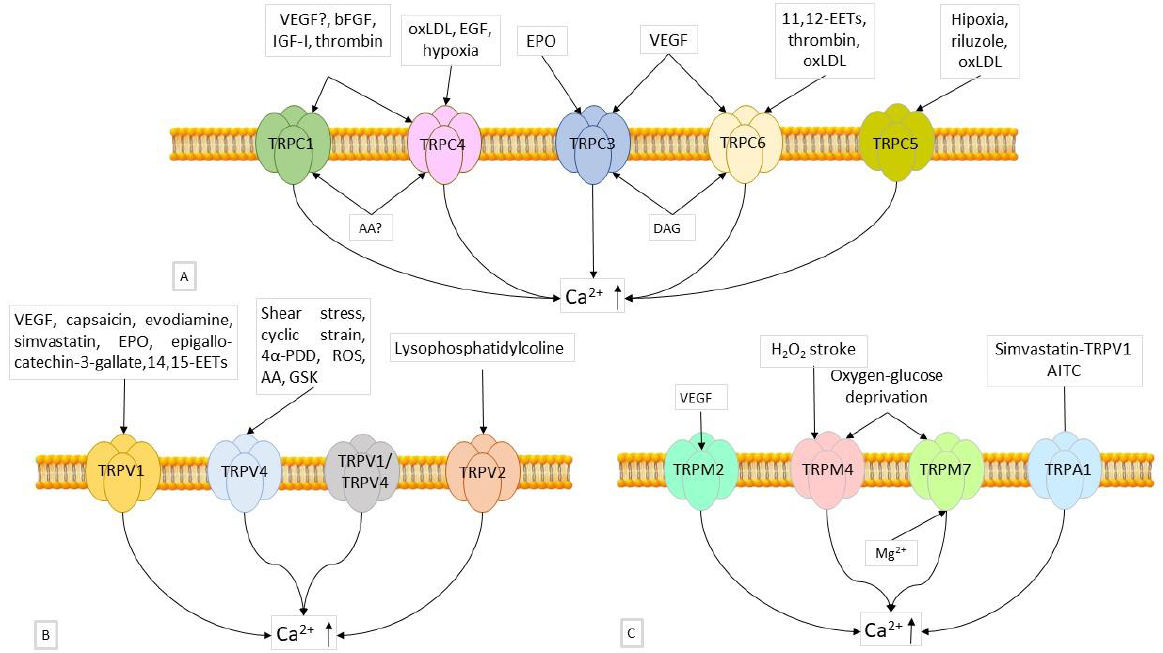
Figure 1. ( A ) TRPC channels in angiogenesis. Representation of the main TRPC channels involved in angiogenesis. The factors that stimulate the expression of the different components are shown. VEGF, IGF, bFGF, and thrombin induce expression of TRPC1; EGF, oxLDL, and hypoxic condition induce expression of TRPC4; erythropoietin (EPO) and VEGF induce expression of TRPC3; oxLDL,